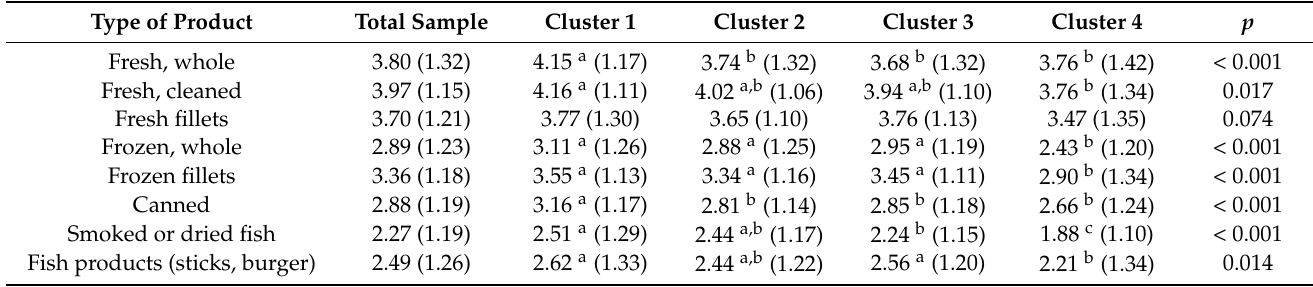
Table 5. Preference for type of products among Croatian fishery consumers (n = 977).